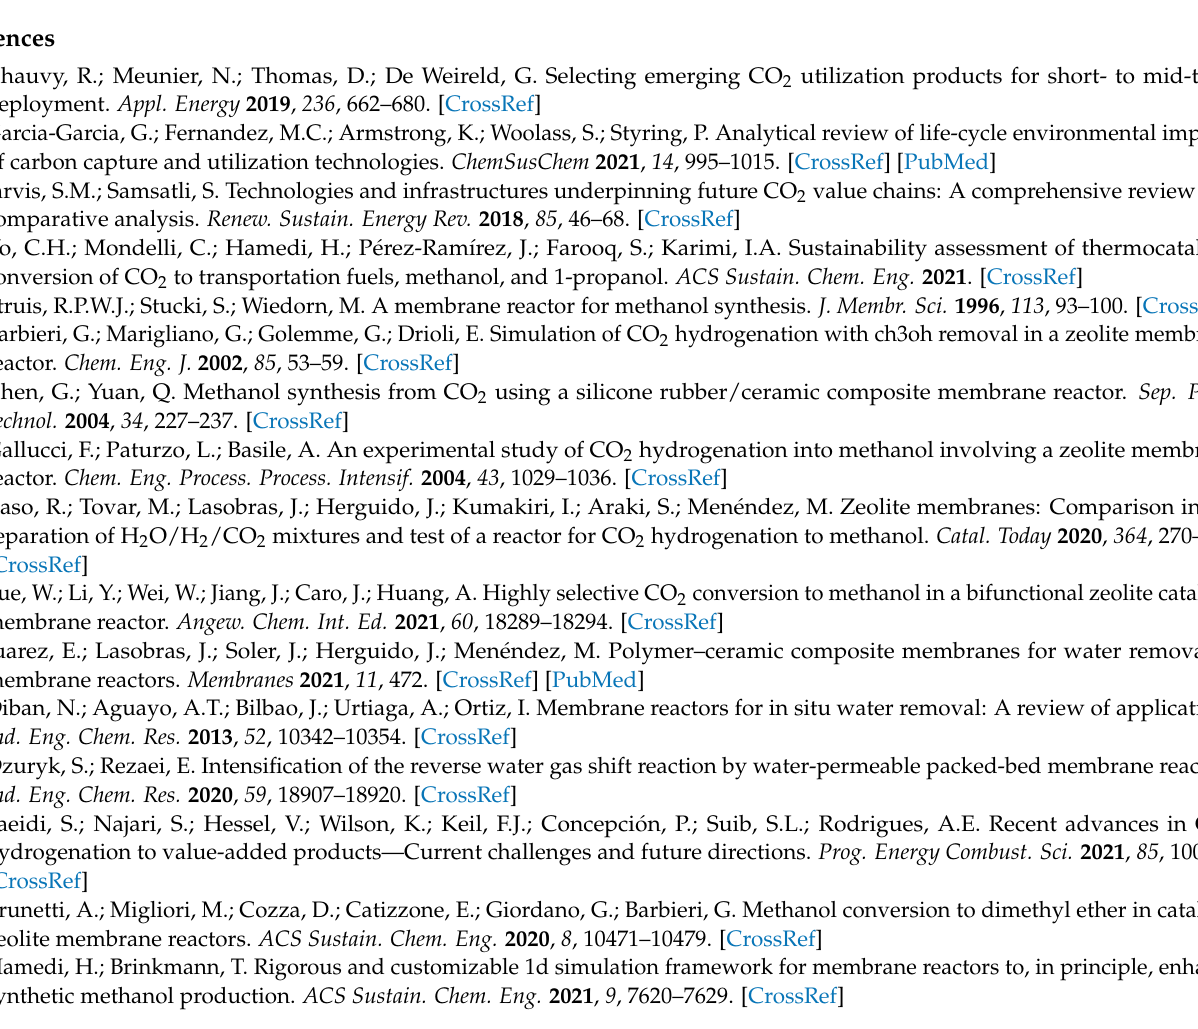
Figure A1. MR-based methanol production process flowsheet diagram simulated in Aspen HYSYS V11.